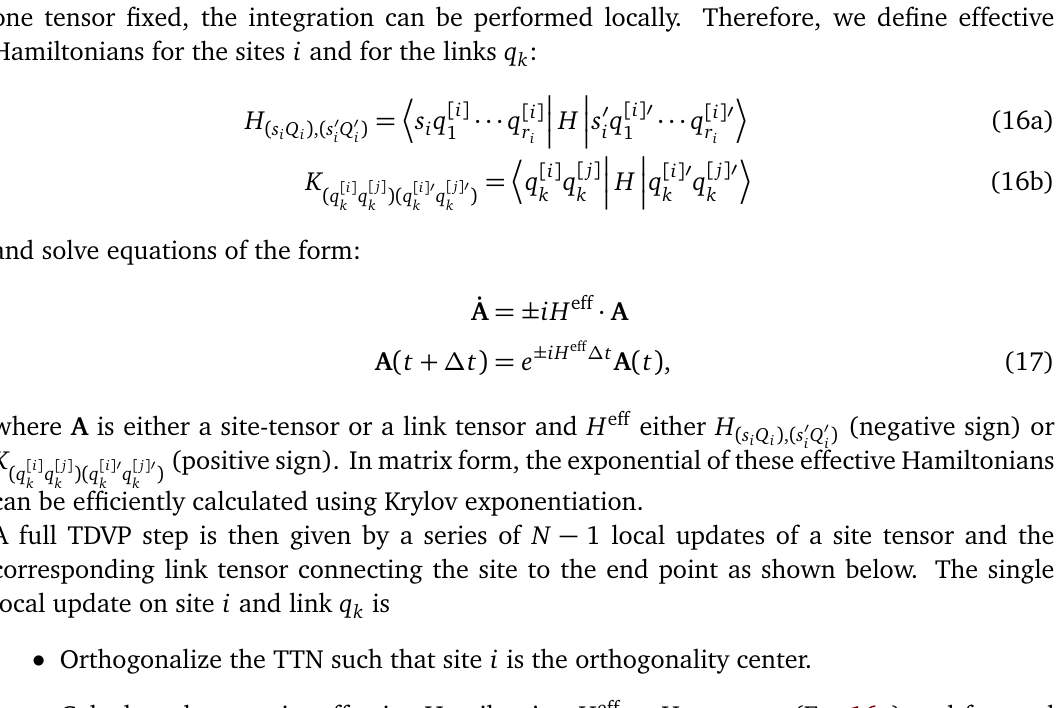
connecting sites i = 4 and j = 1